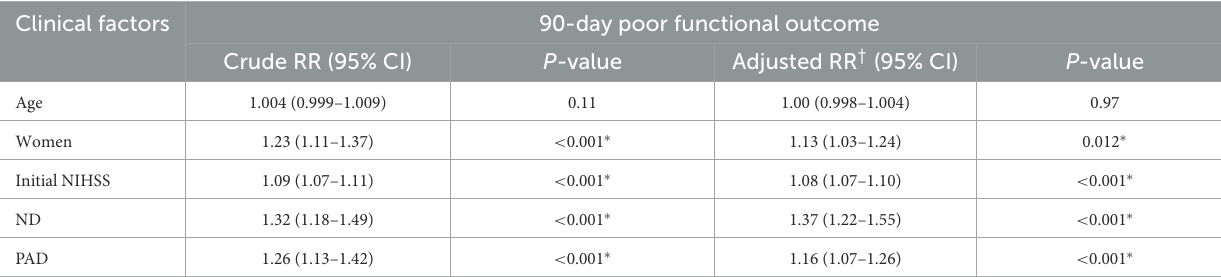
TABLE 3 Independent predictors of a 90-day poor functional outcome in patients with SSI. Clinical